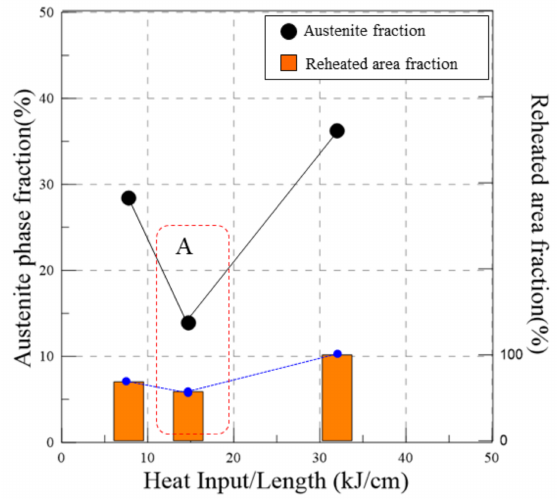
Figure 17. Comparison of the austenite fraction and the reheated area fraction at the edge